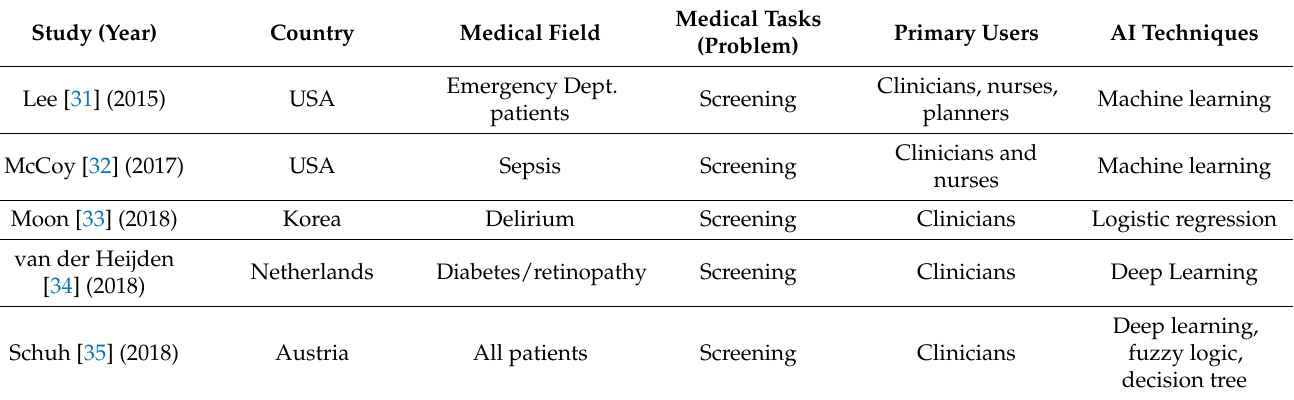
Figure 2. PRISMA flow diagram based on the template by Page et al. [30]. Study characteristics and critical appraisal. Table 3. Properties of the included